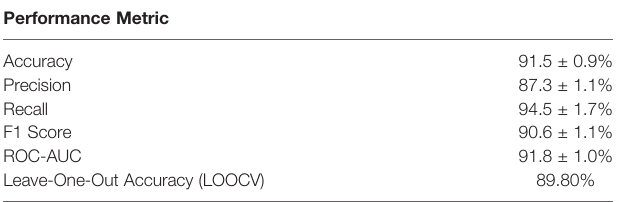
TABLE 5 | Performance metrics for voting model, calculated over 1,000 test